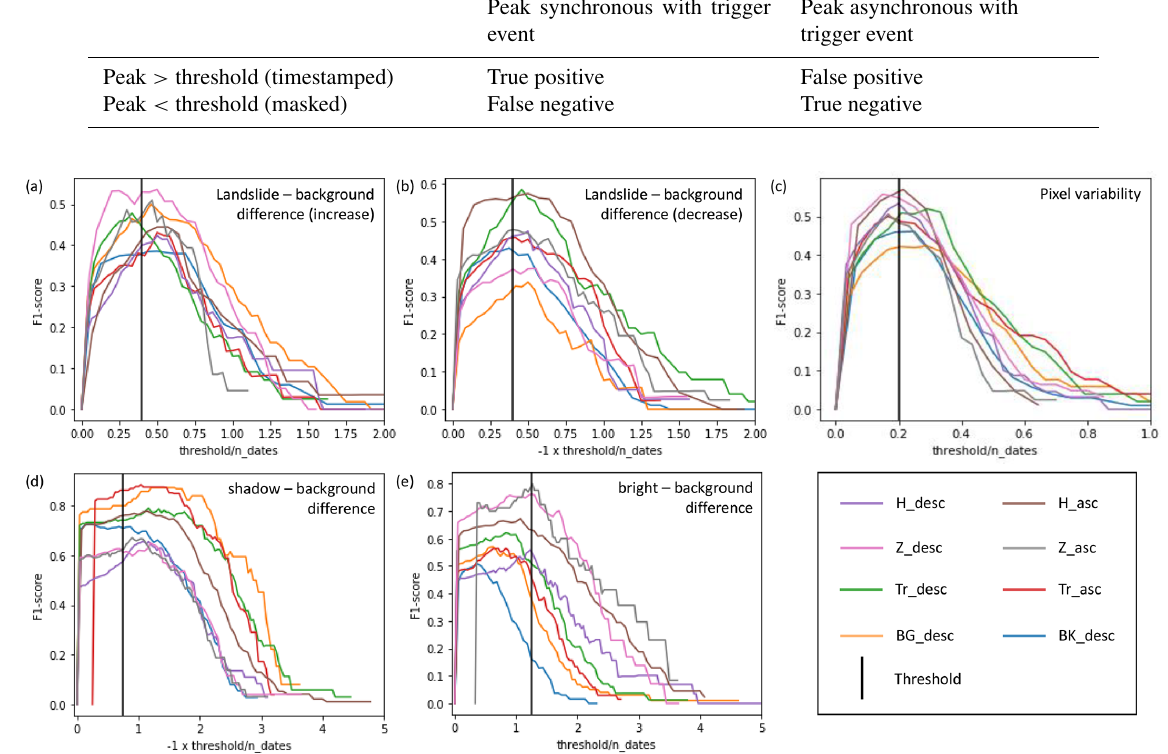
Figure 3. F1 scores for a range of peak thresholds for the landslide–background ( a and b correspond to step increase and decrease respec- tively), pixel variability (c) , geometric-shadow (d) and geometric-bright-spot (e) techniques. Vertical black lines show selected